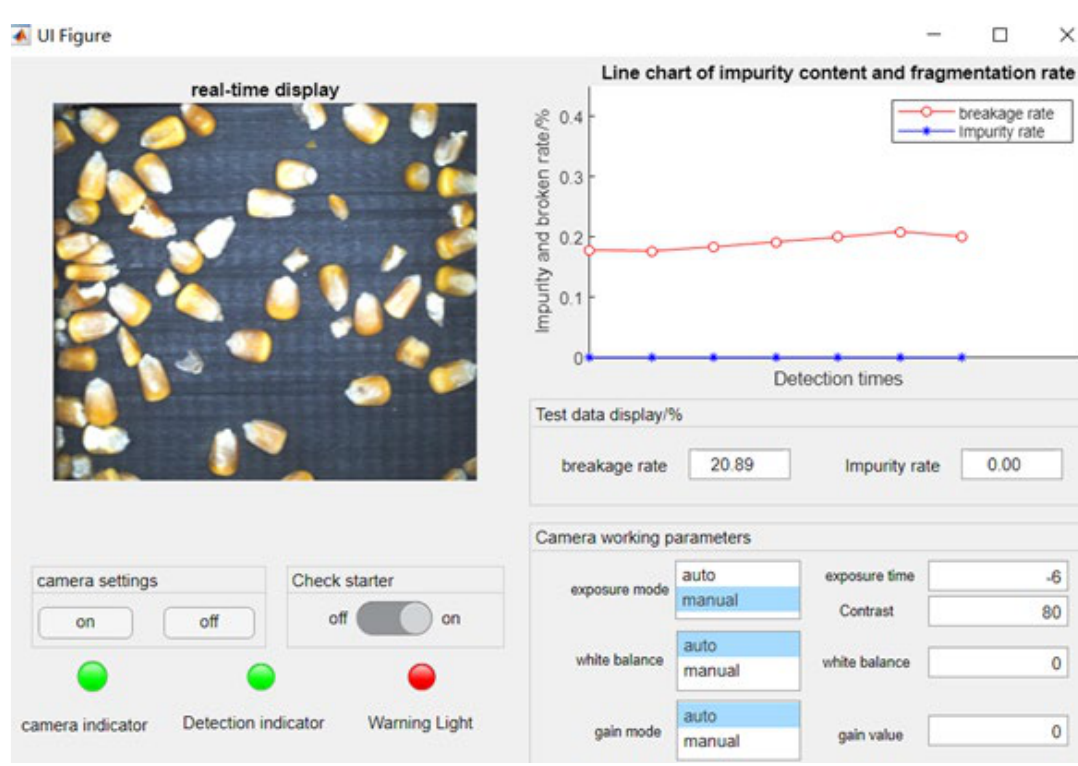
Figure 10. Online monitoring software interface.